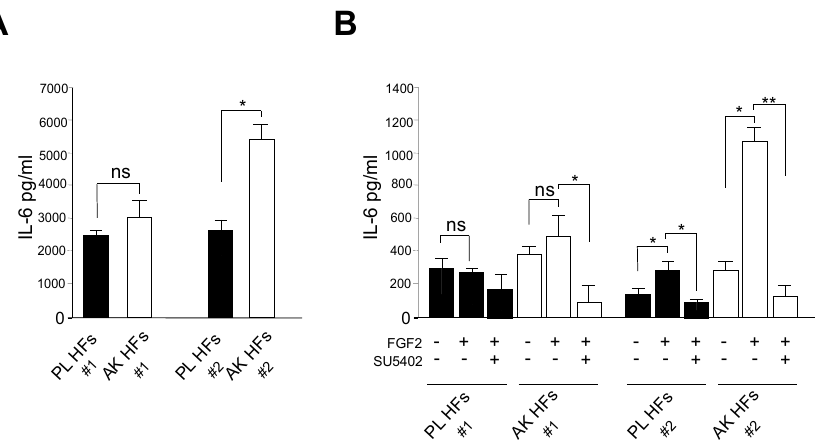
Figure 8. In AK KIN I-derived HFs, the increased secretion of IL-6 depends on FGFR2c high expression and signaling. Primary cultures of HFs from #1PL, #1AK, #2PL, and #2AK samples were left in serum ( A ) or serum starved and stimulated with FGF2 in the presence or not of the SU5402 ( B ). Magnetic bead-based multiplex assay performed on cell supernatants (SN) shows that the IL-6 protein levels from serum-fed #2AK cells are significantly higher compared to those detected in the SN from the corresponding PL controls or from both #1AK and #1PL cultures ( A ). In #2AK cells, the levels of IL-6 released in the SN are significantly increased by FGF2 stimulation but strongly dampened by SU5402 ( B ). The values are expressed in pg/mL. Results are expressed as mean values ± SD. The student’s t-test was performed, and significance levels are defined as p < 0.05. * p < 0.05; ** p < 0.01; ns not signi fi cant.